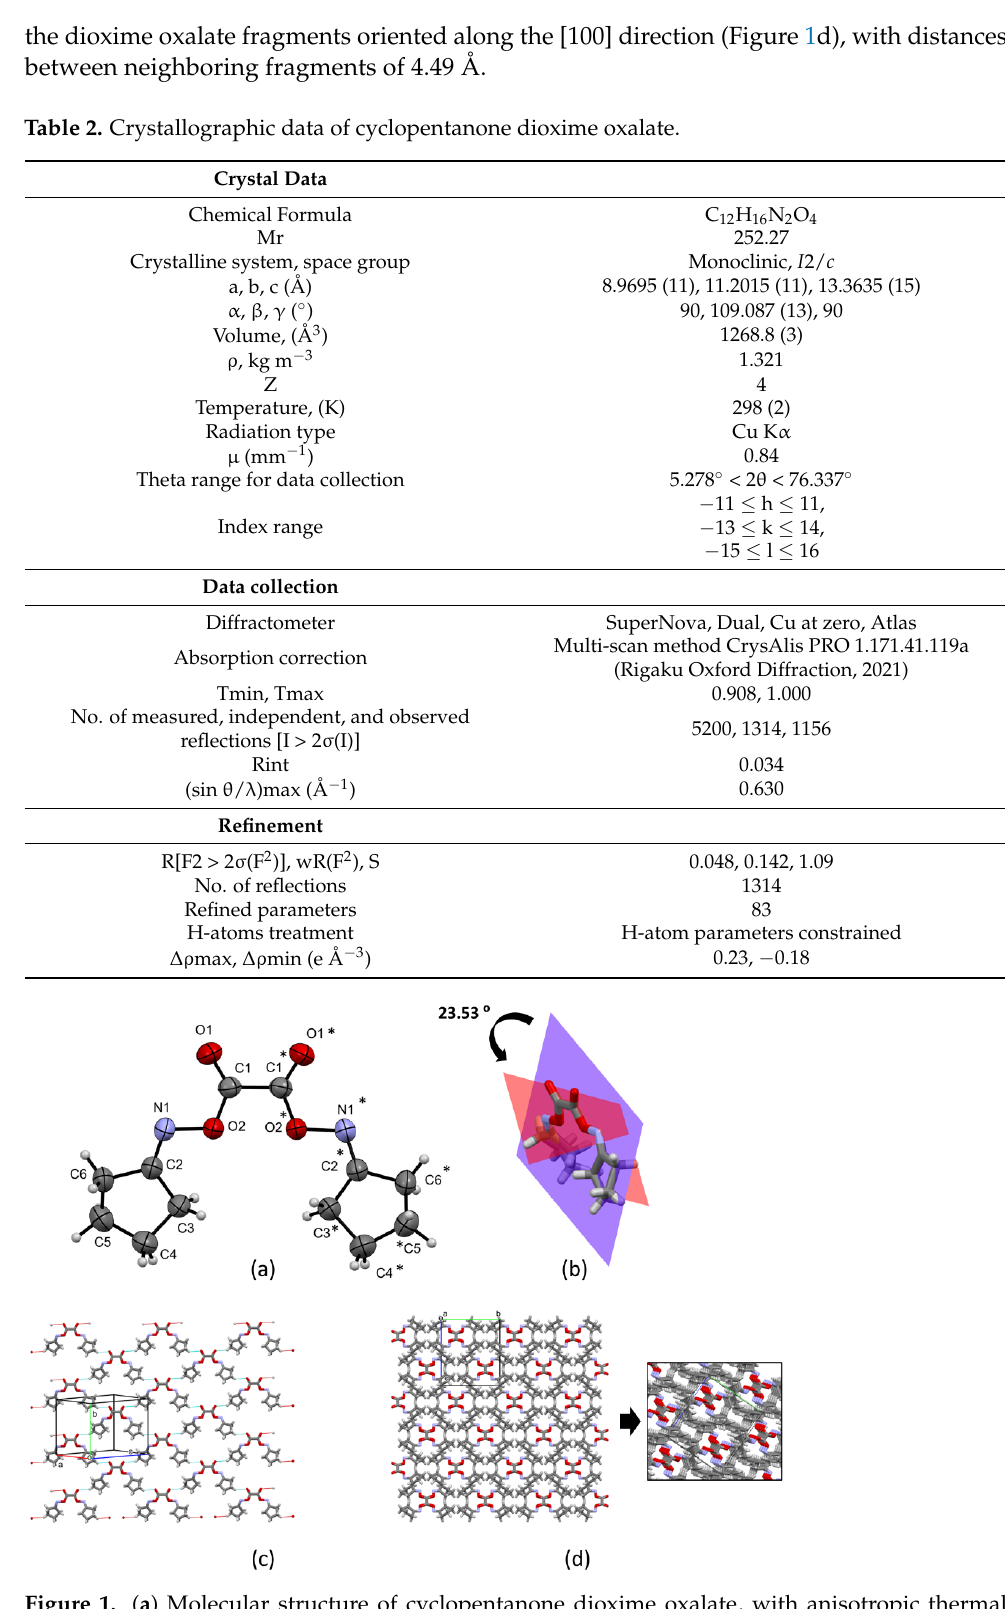
Figure 1. ( a ) Molecular structure of cyclopentanone dioxime oxalate, with anisotropic thermal vibration ellipsoids drawn at the 50% probability level. The hydrogen atoms are shown as spheres of arbitrary radius. ( b ) Dihedral angle between cyclopentane moieties and dioxime oxalate fragment. ( c ) Molecular sheets are formed by C-H ‧‧‧ O hydrogen interactions. ( d ) Packing showing dioxime oxalate fragments oriented along the [100] direction.